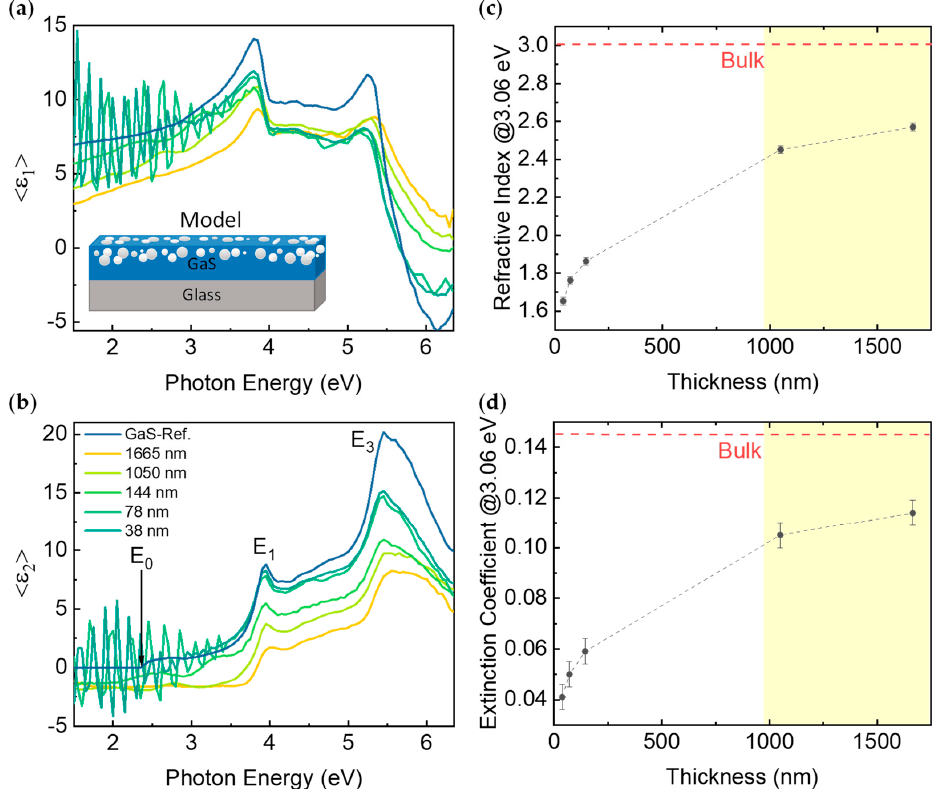
Figure 3. ( a ) Real 〈 ε 1 〉 , and ( b ) imaginary, 〈 ε 2 〉 , parts of the pseudodielectric function, 〈 ε 〉 = 〈 ε 1 〉 + Figure 3. ( a ) Real ⟨ ε 1 ⟩ , and ( b ) imaginary, ⟨ ε 2 ⟩ , parts of the pseudodielectric function, ⟨ ε ⟩ = ⟨ ε 1 ⟩ + i 〈 ε 2 〉 , of exfoliated GaS with different thicknesses. ( c ) Extinction coefficient and ( d ) refractive index at i ⟨ ε 2 ⟩ , of exfoliated GaS with different thicknesses. ( c ) Extinction coefficient and ( d ) refractive index 3.06 eV as a function of thickness. The reference values for the refractive index of bulk crystal GaS are at 3.06 eV as a function of thickness. The reference values for the refractive index of bulk crystal also shown for comparison. The error bar on the refractive index and extinction coefficient comes GaS are also shown for comparison. The error bar on the refractive index and extinction coefficient comes from the errors on the GaS volume fraction percentage and voids volume fraction percent- from the errors on the GaS volume fraction percentage and voids volume fraction percentage of the age of the BEMA approximation of the ellipsometric fitting. BEMA approximation of the ellipsometric